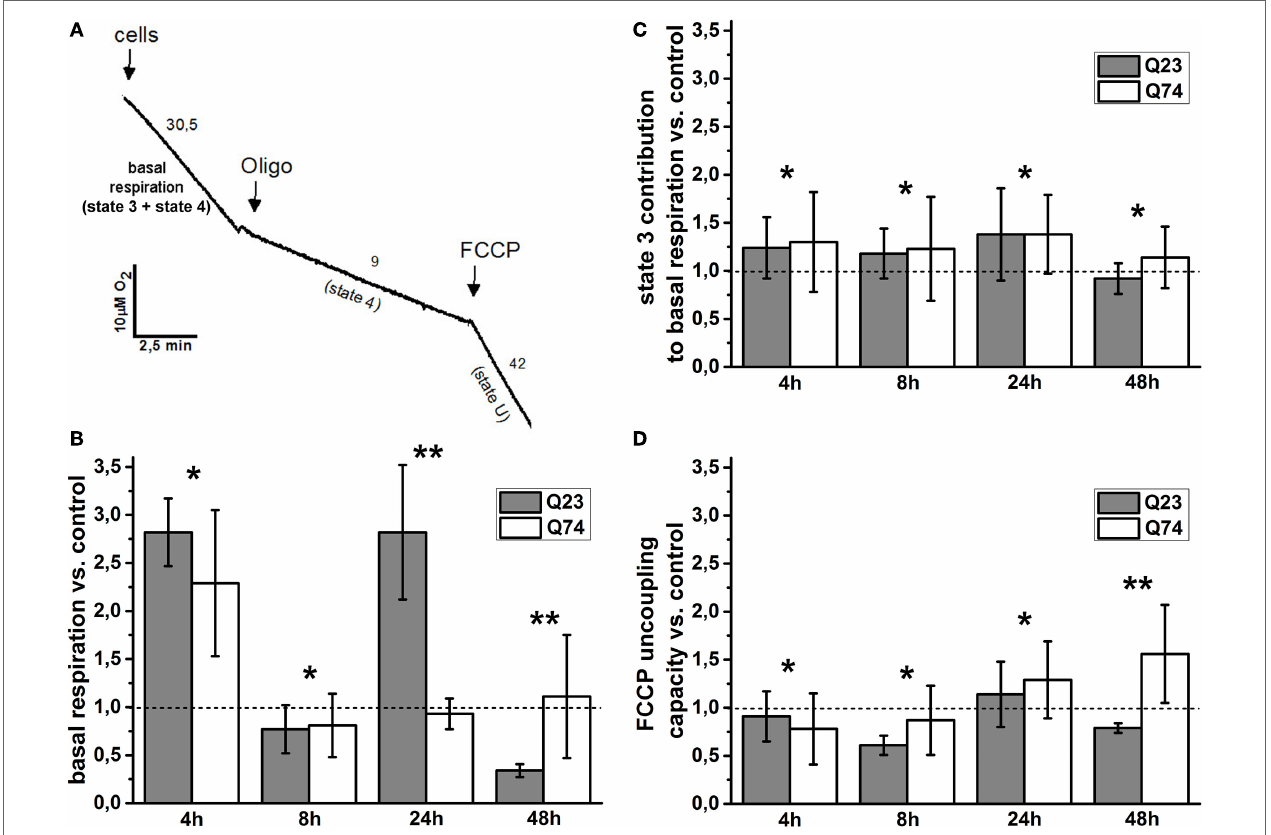
FigUre 2 | changes of the mitochondrial coupling status in intact Pc12 hD-Q23 and Pc12 hD-Q74 cells with expression of htt and mhtt, respectively, induced for a given period of time . (a) A representative trace applied for further calculations. The rate of oxygen uptake by cells (2 × 10 6 ) was measured at 37°C in DMEM. Oligo, oligomycin. The calculated values of the change index for (B) basal respiration, (c) state 3 contribution to basal respiration, and (D) FCCP uncoupling capacity. The change index was calculated between cells expressing Htt or mHtt and control cells, i.e., cultured for the same time but without Htt or mHtt expression. State 4 was enforced by the addition of 2 μ g/ml oligomycin, and state 3 was calculated by subtracting state 4 from basal respiration. The optimal concentration of FCCP yielding the highest respiratory rate (state U) was settled by the uncoupler addition in portions of 1 μ M each. The FCCP uncoupling capacity denotes state U to state 4 ratio. The data are presented as mean values ± SD of three independent experiments. Statistical analysis was based on t -test: * – not statistically significant, ** – statistically significant ( p <